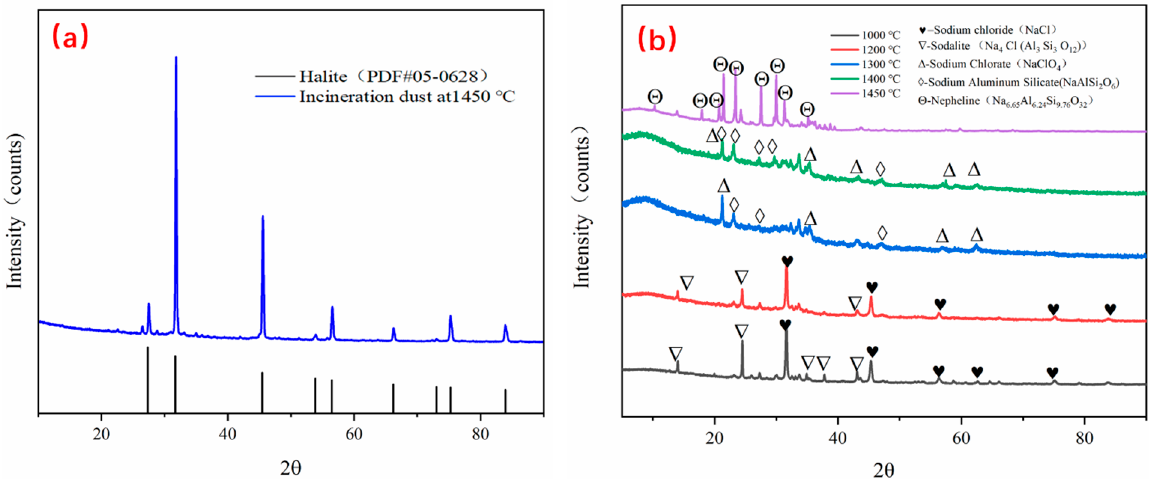
Figure 6. ( a ) XRD spectra of soot collected in fly ash smelting at 1450 °C and Halite standard spectra; ( b ) XRD spectra of the slag at different temperatures.